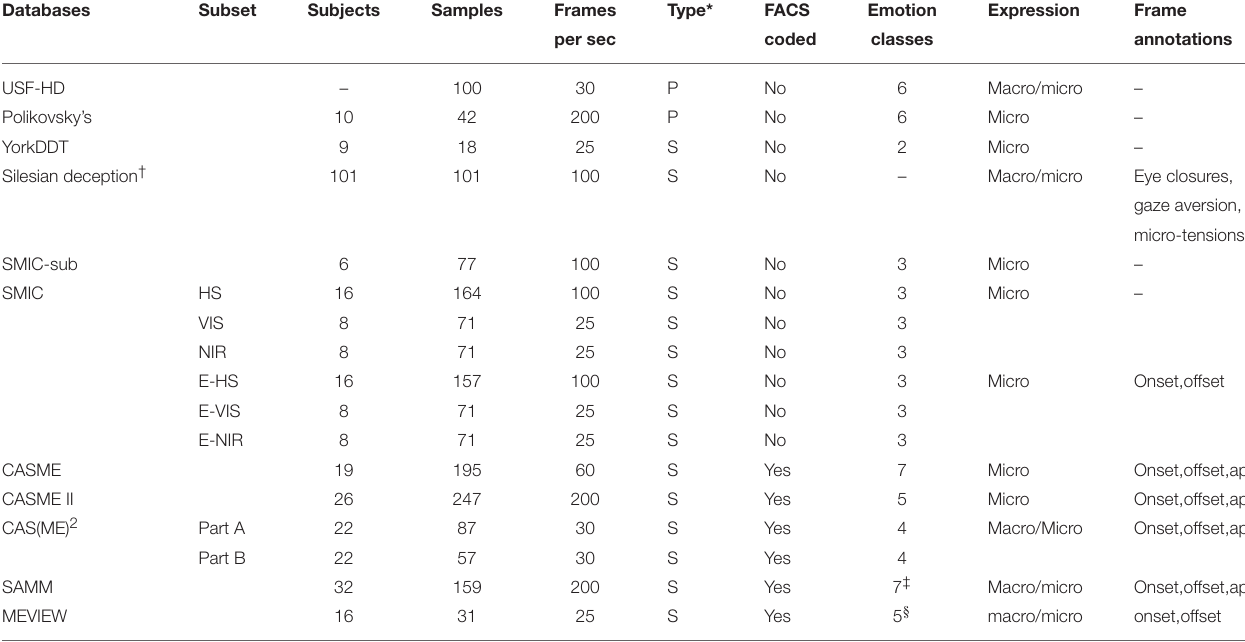
TABLE 1 | Micro-expression databases.